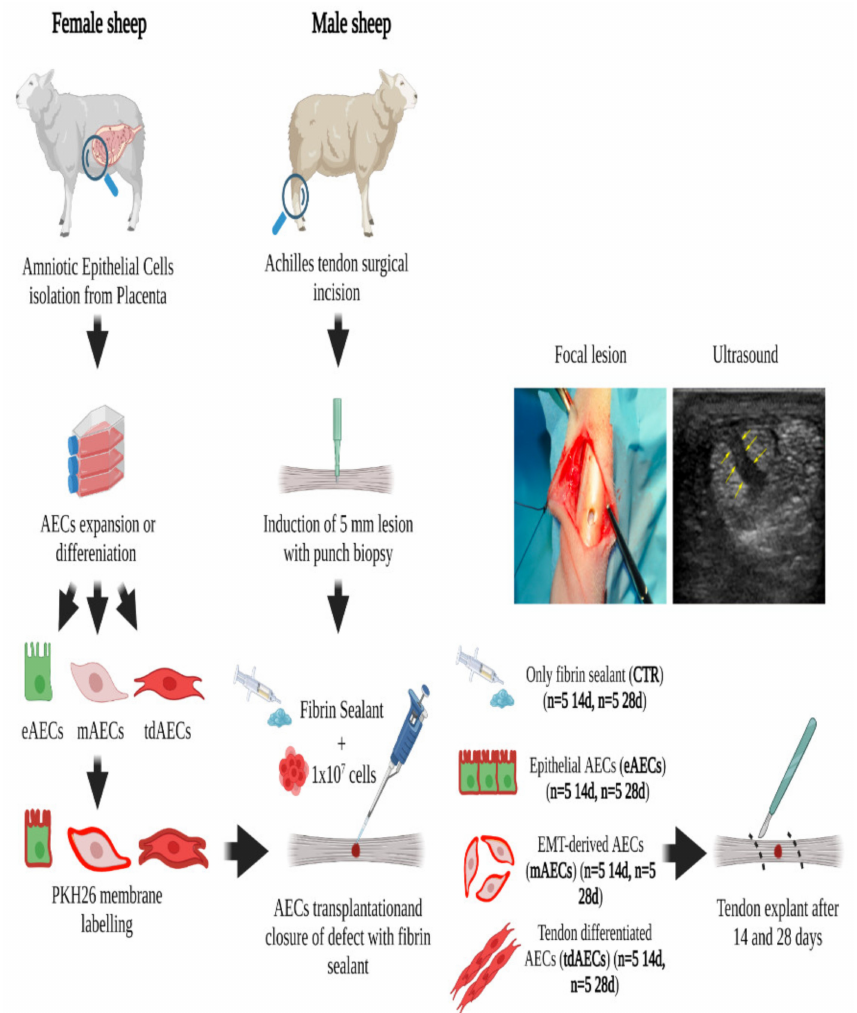
Figure 1. Animal experimental design. Workflow of the animal experimental design in which different subsets of oAECs (eAECs, mAECs, tdAECs) were allotransplanted into a validated sheep Achilles tendon injury model. In the Figure, a representative image of the focal lesion carried out with the biopsy punch and the corresponding US image showing the hypoechoic area corresponding to the lesion within the tendon (yellow